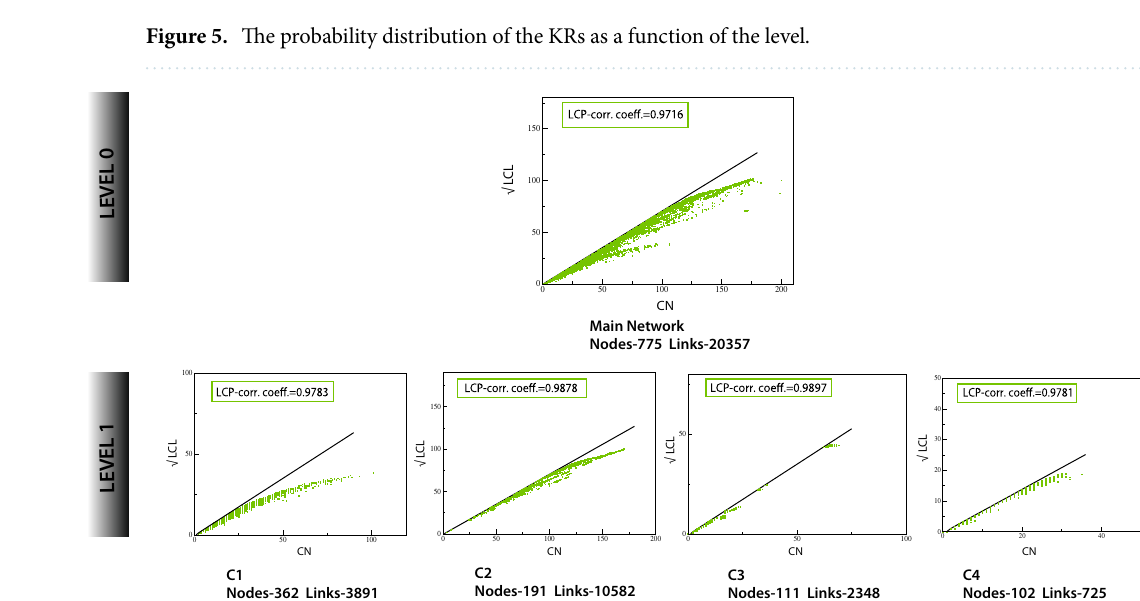
Figure 6. LCP-DP plots of main TS network (Level 0) and modules/sub-modules at the first level of organization of TS